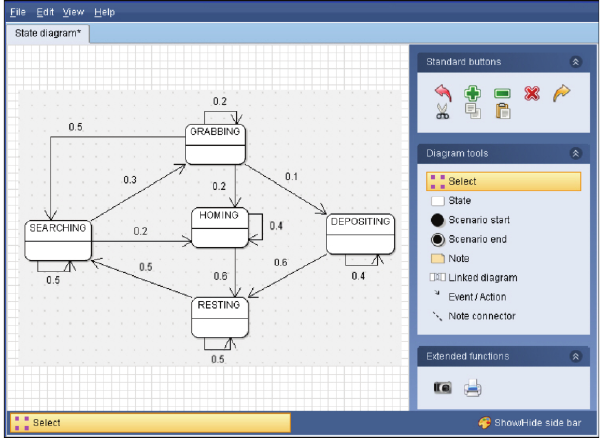
Figure 4: A probabilistic state machine constructed in DP